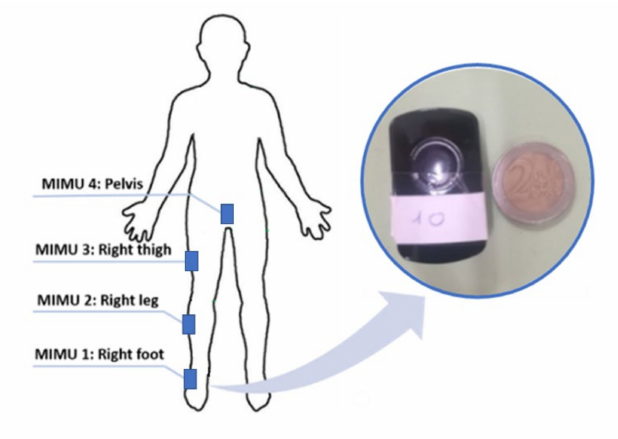
Figure 1. Magneto-inertial measurement units (MIMUs) placement